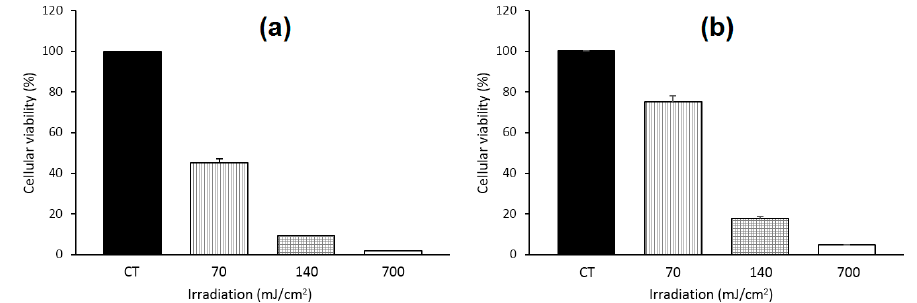
Figure 8. Cellular viability of J774-A1 after treatment with ( a ) CIAlPc/HP- β -CD and ( b ) CIAlPc/ β -CD complexes under various irradiation. The cells were exposed to increasing doses of light at 70 mJ/cm 2 , 140 mJ/cm 2 , and 700 mJ/cm 2 ( a ) p -values < 0.001 and ( b ) p -values < 0.05 in relation to the respective control. Data is expressed as means ± SD ( n = 3). Adapted from Silva; Simioni; Tedesco [123].